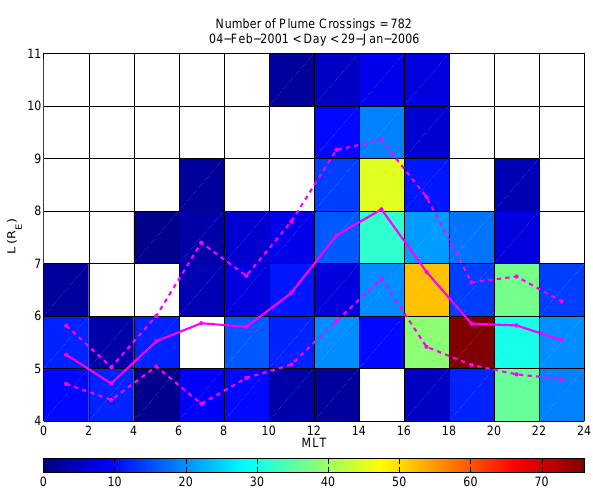
Fig. 11. Distribution of plasmaspheric plumes observed by WHIS- PER onboard Cluster during the five years of data analysed. The L position of the plume is shown as a function of MLT. The color code gives the number of events in each bin. The solid magenta curve gives the mean L value inside each MLT range, and the two dashed magenta curves the standard deviation of this